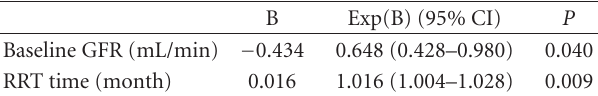
Table 3: Multivariate Cox proportional hazard analysis of variables significantly associated with UFF-free survival. Sex, age, diabetes, APD, and peritonitis did not significantly impact on UFF-free survival. B Exp(B) (95%